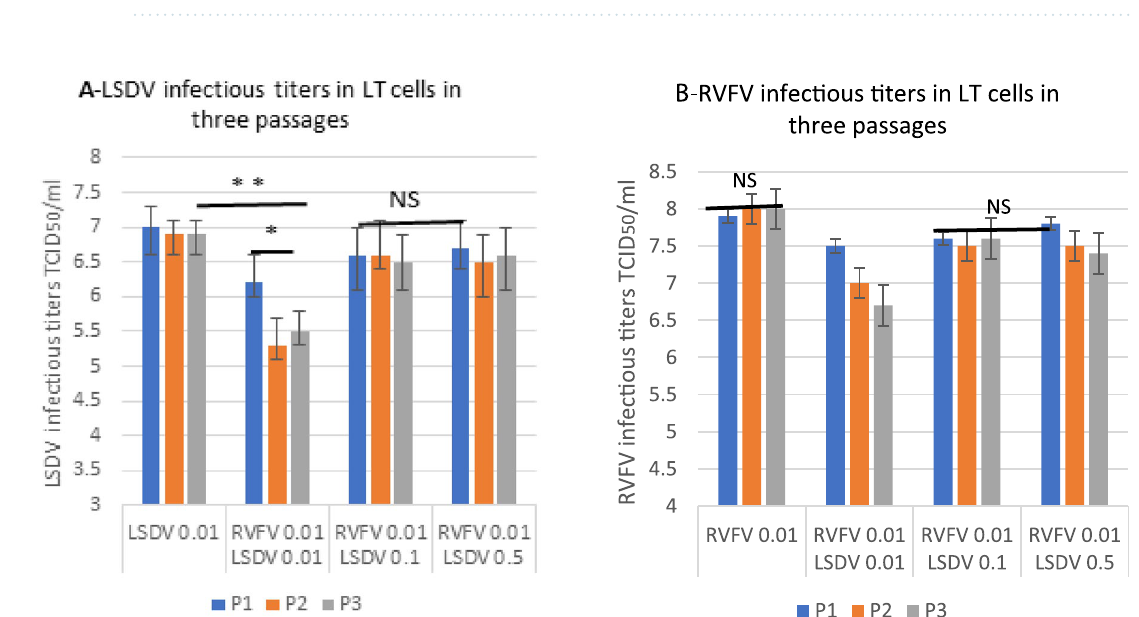
Figure 3. Infectivity titration (TCID 50 /ml) and viral genome copies by qPCR (threshold cycles: Ct) of SPPV ( A ) and RVFV ( B ) after coinfection in three successive passages (P1, P2 and P3). Infection was performed in (LT cells with different MOIs (RVFV/SPPV: 0.01/0.01; 0.01/0.1; 0.01/0.25; 0.01/0.5; 0.01/1). Data shown are means of at least three independent experiments.